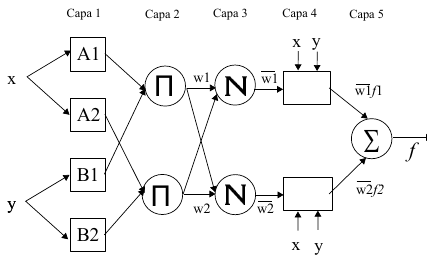
Figure 3. General structure of